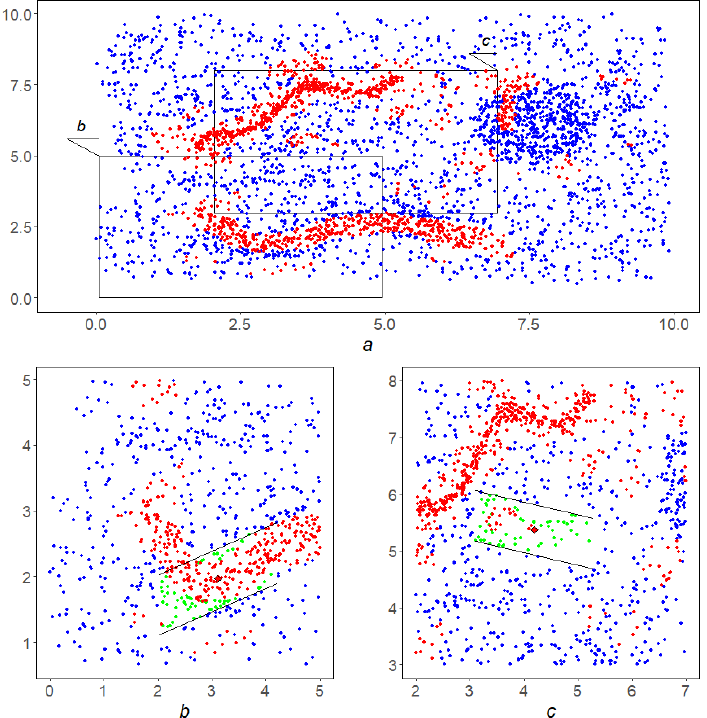
Figure 13. The second stage of the algorithm. ( a ) The original array with the selected base (red dots); ( b ) points from in the corridor from Figure 12b; and ( c ) points from in the corridor from Figure 12c. The position of the fragments of the original array shown in figures ( b ), ( c ) is indicated by the leaders in figure ( a